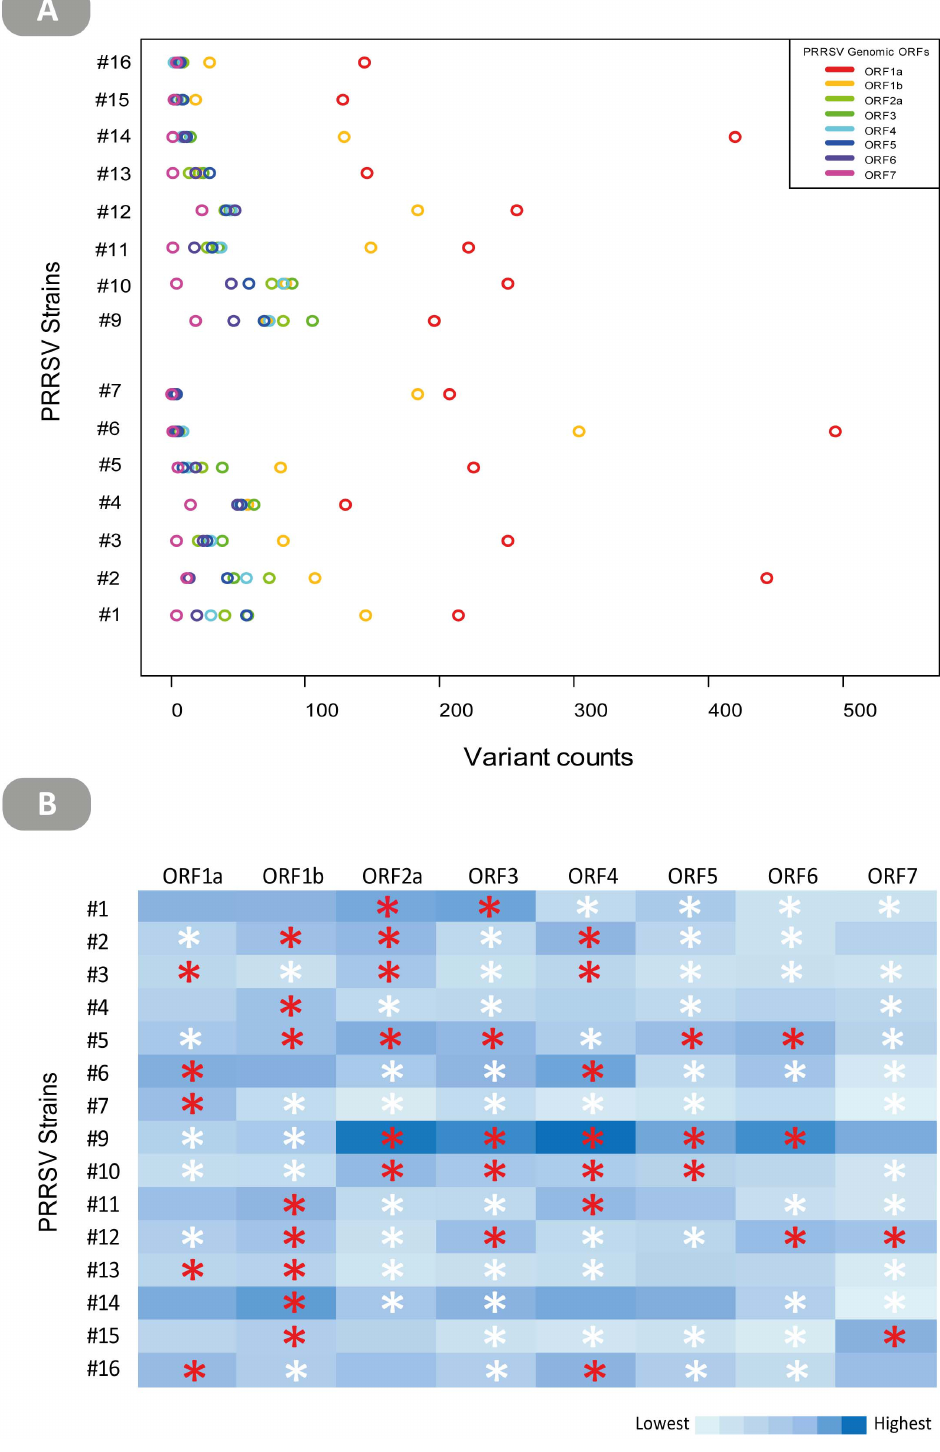
Figure 3. Genetic complexity arising from nucleotide variants across ORFs of different PRRSV strains. The quantitative measure of mean normalized Shannon ( Sn ) entropy accommodated for differences in sequencing depth and variable ORF sizes. Open ( # ) and closed ( represented ORF and genomic mean Sn entropies respectively. doi:10.1371/journal.pone.0088807.g003 Aside from the consequence on the protein sequence, in silico assessments of the impact of nonsynonymous variants on protein structure were made using two independent predictive tools PLOS ONE |